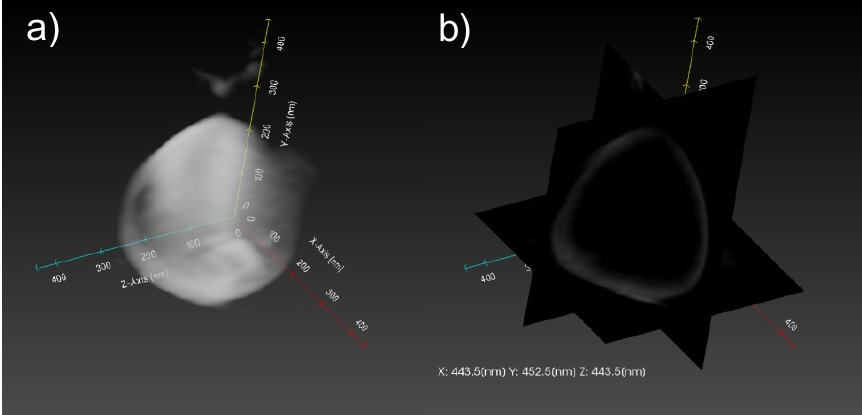
Figure 6. ( a ) 3D-TEM and ( b ) tomography images of CaCO 3 -coated vesicle for 18-day mineralization. Axis length information; X axis: 443.5 nm; Y axis: 452.5 nm; Z axis: 443.5 nm.